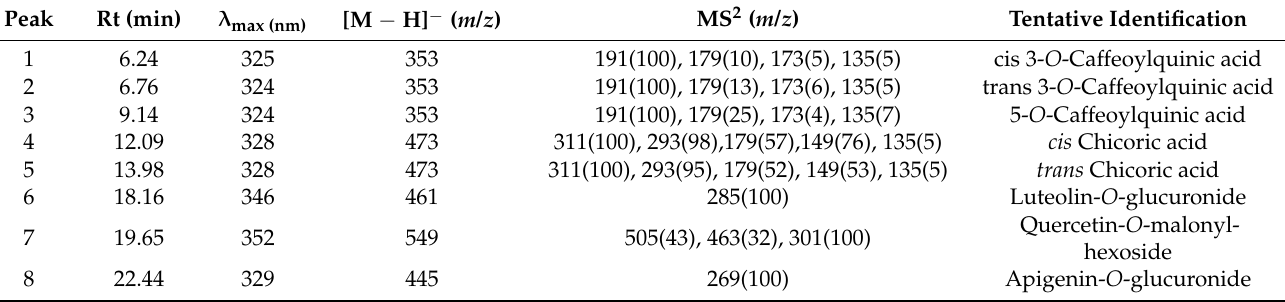
Table 3. Retention time (Rt), wavelengths of maximum absorption in the visible region ( λ max ), mass spectral data, and tentative identification of the phenolic compounds present in the infusion preparations and hydroethanolic extracts of L. canadensis .